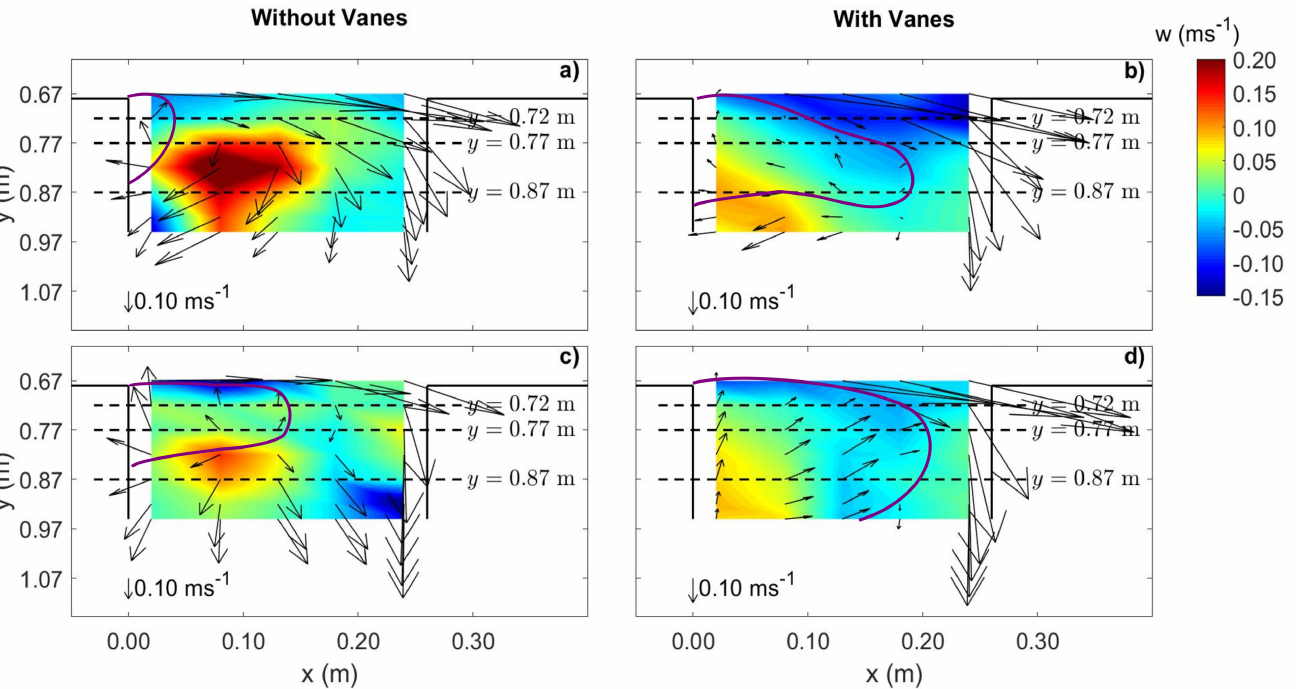
Figure 13. Vertical velocity w (ms − 1 ) as color scale and direction and magnitude of the velocity components in the diversion entrance zone ( u , v ) (ms − 1 ) as vector arrows, in the NV and the VF experiments, at horizontal plans: ( a ) z = 0.017 m. ( b ) z = 0.015 m. ( c ) z = 0.062 m. ( d ) z = 0.065